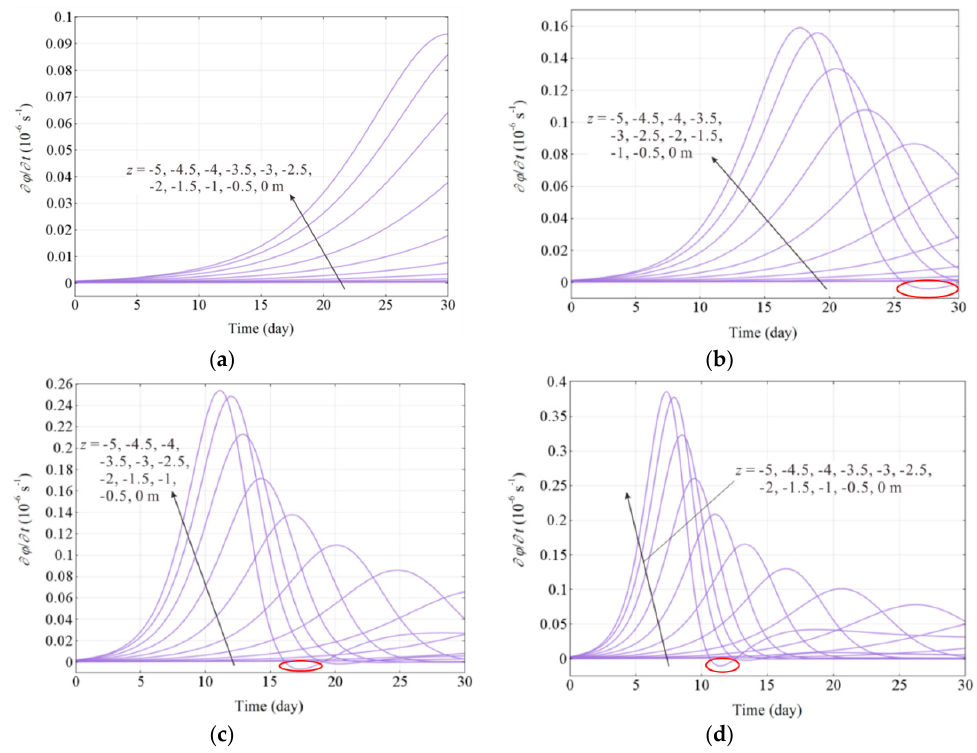
Figure 12. Variations of ∂ϕ ∂ t for different wave heights: ( a ) H = 1.50 m; ( b ) H = 2.00 m; ( c ) H = 2.25 m; ( d ) H = 2.50 m.